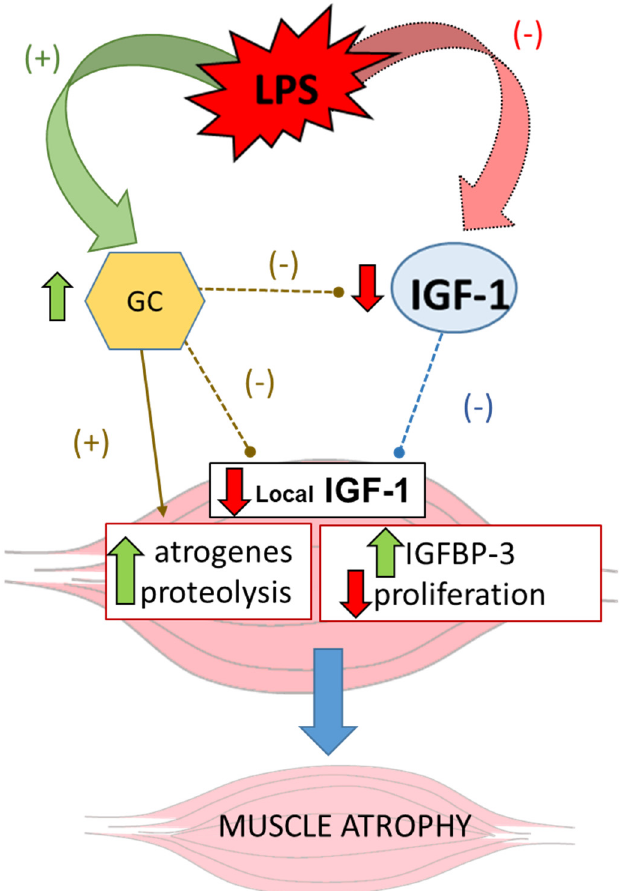
Figure 2. Role of IGF-1 in inflammation-induced muscle atrophy. The decreased secretion of GH and/or GH resistance, together with the increased release of glucocorticoids (+) induce downregulation of plasma and muscle IGF-1 ( − ), and the increase in muscle IGFBP-3. Low plasma IGF-1 and high glucocorticoid levels increase atrogenes expression (MuRF-1 and atrogin-1), activate muscle proteolysis by the ubiquitin–proteasome system, and decrease protein synthesis. The increased IGFBP-3 expression together with the low IGF-1 levels in muscles decrease muscle proliferation. Thin arrows indicate stimulatory (+) and dotted ones inhibitory ( − ) effects of GC (green) and IGF-1 (blue) on muscle. Thick arrows indicate stimulation (green upward arrows) and inhibition (red downward arrows) of molecules/processes in muscle.